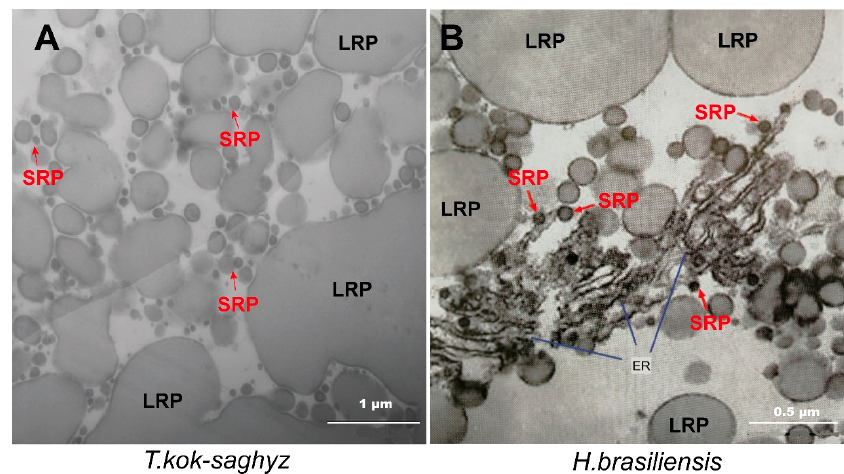
Figure 5. Morphological patterns of rubber particles in laticifer cells of the rubber grass T. kok-saghyz and rubber tree H. brasiliensis . Many pear-like and spherical large rubber particles (LRP, black color) and small rubber particles (SRP, red color) can be detected under a TEM, and typical ultrastructural patterns of these rubber particles in T. kok-saghyz ( A ) and H. brasiliensis ( B ) are highlighted.